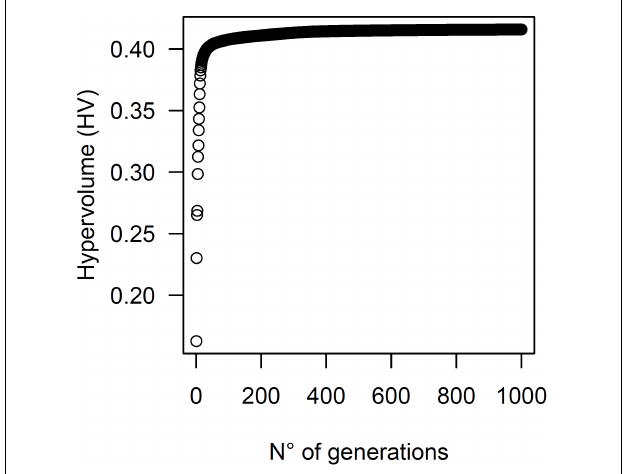
FIGURE 4 | Evolution of the hypervolume over all generations for the land use optimization using